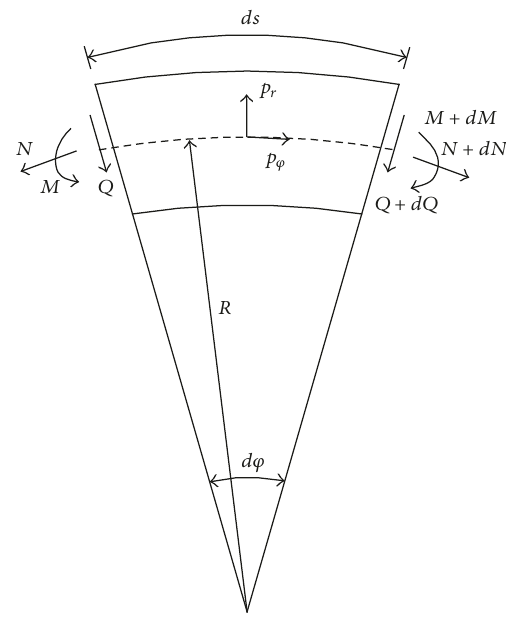
Figure 5: Force analysis of a